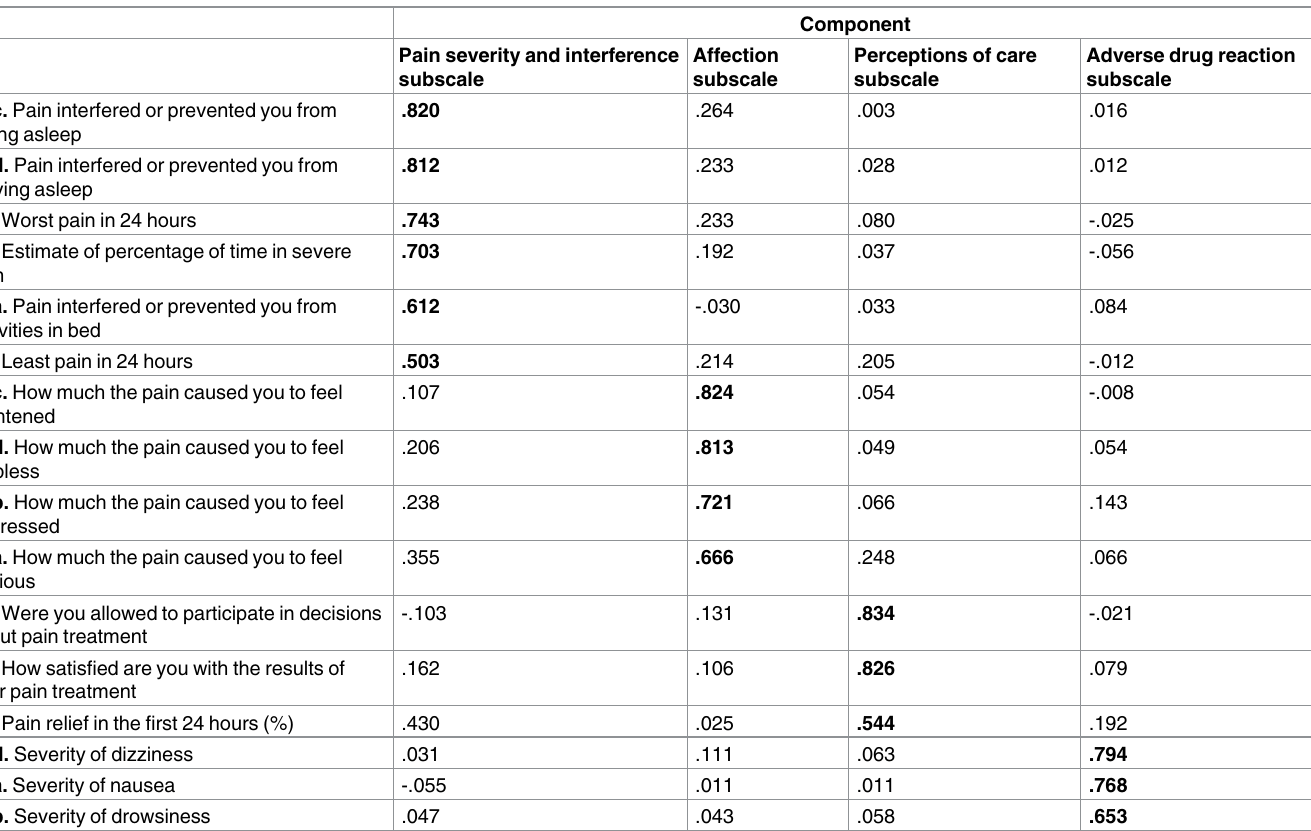
Table 2. Component loading and rotated component matrix of adjusted